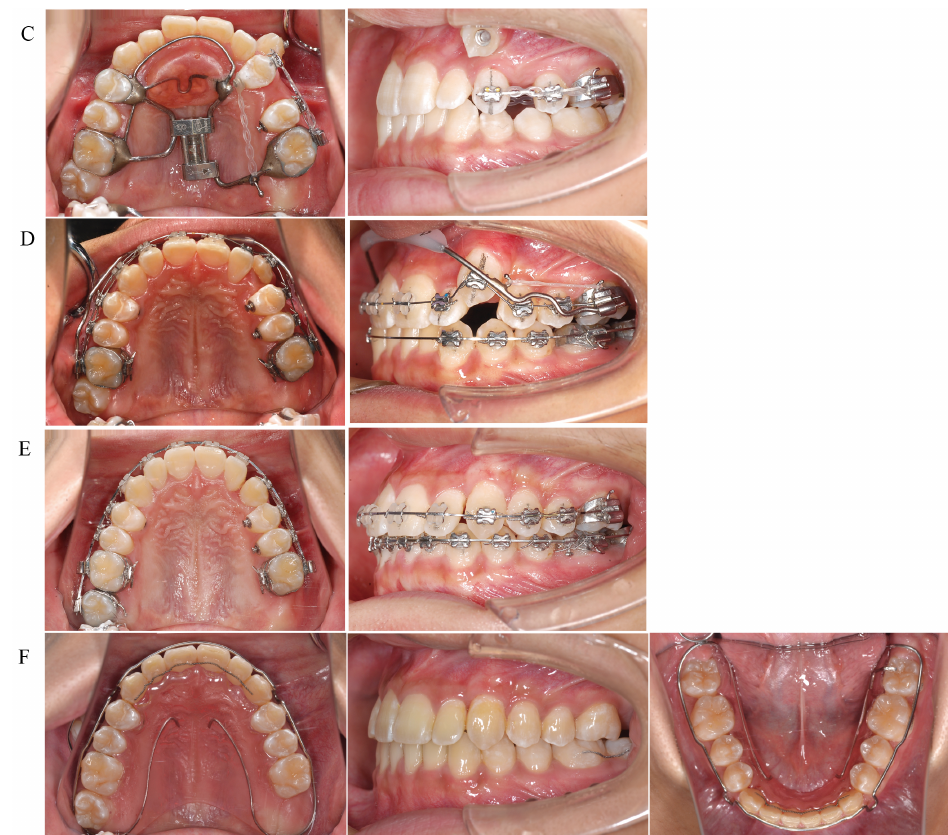
Figure 6. Treatment progress. ( A ) Orthodontic occlusal guidance appliance applied. Distal movement of the maxillary left first molar started. Traction of the maxillary left canine started. ( B ) Distal movement of the maxillary left first molar completed. A sectional archwire was placed on the maxillary left second premolar and first molar to start distal movement of the left second premolar. ( C ) Distal movement of the maxillary left second premolar completed. A sectional archwire was placed from the maxillary left first premolar to the first molar to start distal movement of the left first premolar. ( D ) Distal movement of the maxillary left first premolar completed. Leveling of